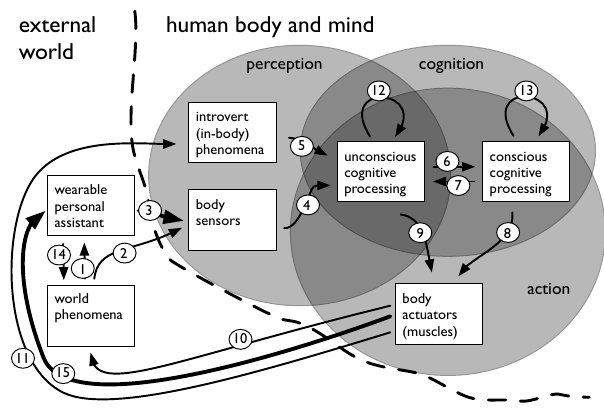
Figure 1. A body-and-mind centric model of how Wearable Personal Assistants fit into the flow of perception, cognition, and action of human agents. [2]